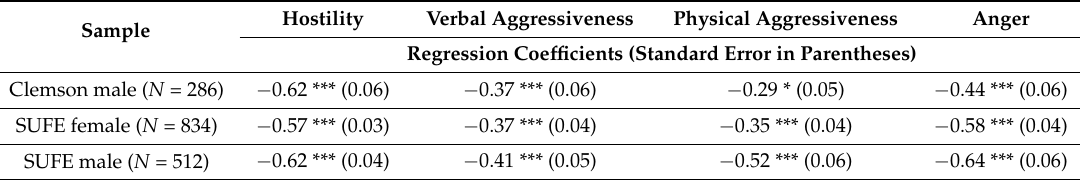
Table 2. Mindfulness and four sub-scales of aggressiveness: linear regressions from two college freshmen samples. Hostility Verbal Aggressiveness Physical Aggressiveness Anger Sample Regression Coefficients (Standard Error in Parentheses) Clemson male ( N = 286) ´ 0.62 *** (0.06) SUFE female ( N =